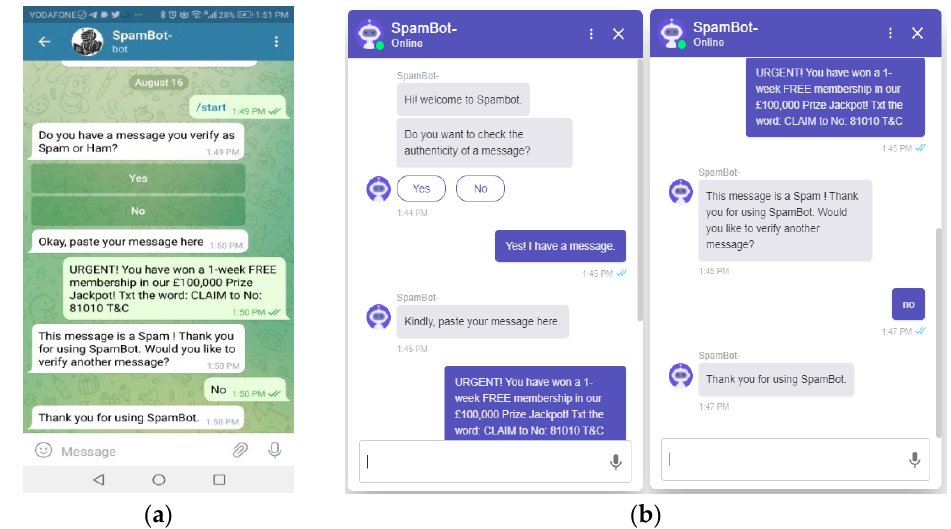
Figure 1. ( a ) Telegram Chatbot ( b ) Website Chatbot.